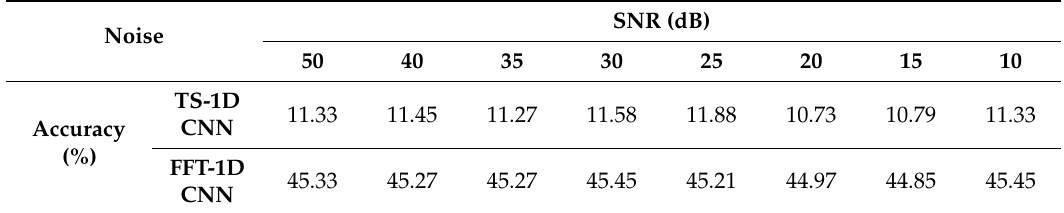
Table 2. Accuracy of damage identification based on time series (TS)- and fast Fourier transform (FFT)-1D CNN frameworks under different noise levels.